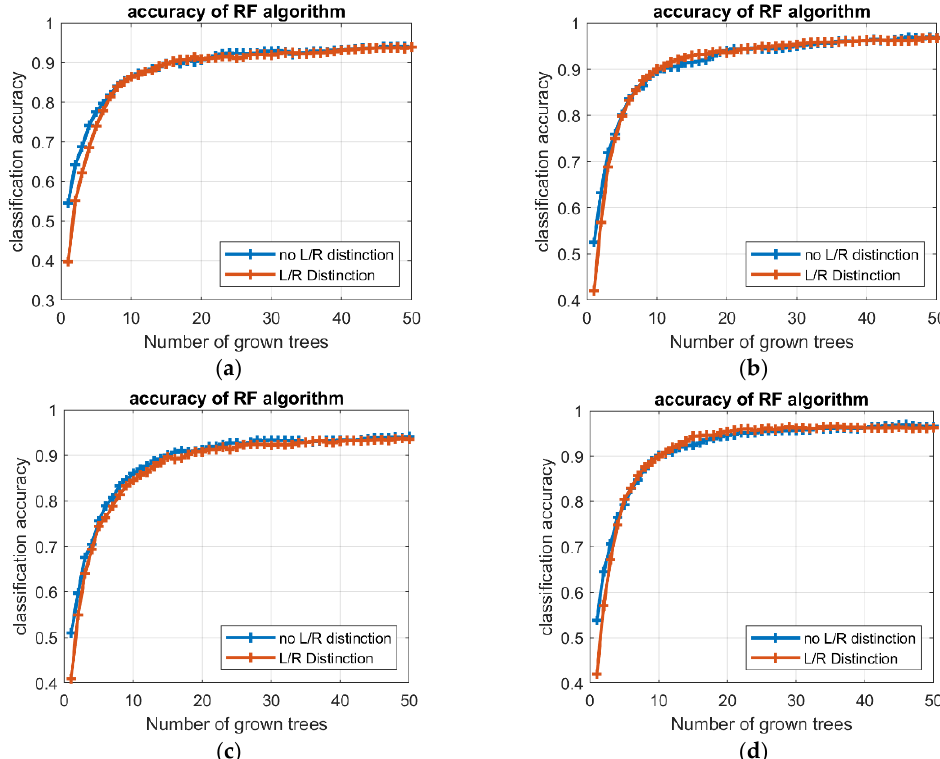
Figure 8. Example of RF accuracy with respect to the number of trees, for ( a ) HD1 (in blue) and HD2 (in red), ( b ) HD3 (in blue) and HD4 (in red), ( c ) HD5 (in blue) and HD6 (in red), and ( d ) HD7 (in blue) and HD8 (in red). Average training time for the RF algorithm was 1.56 s (range: 0.24–0.32), which de- creased to an average value of 0.057 s (range: 0.031–0.072) for LDA. The average prediction